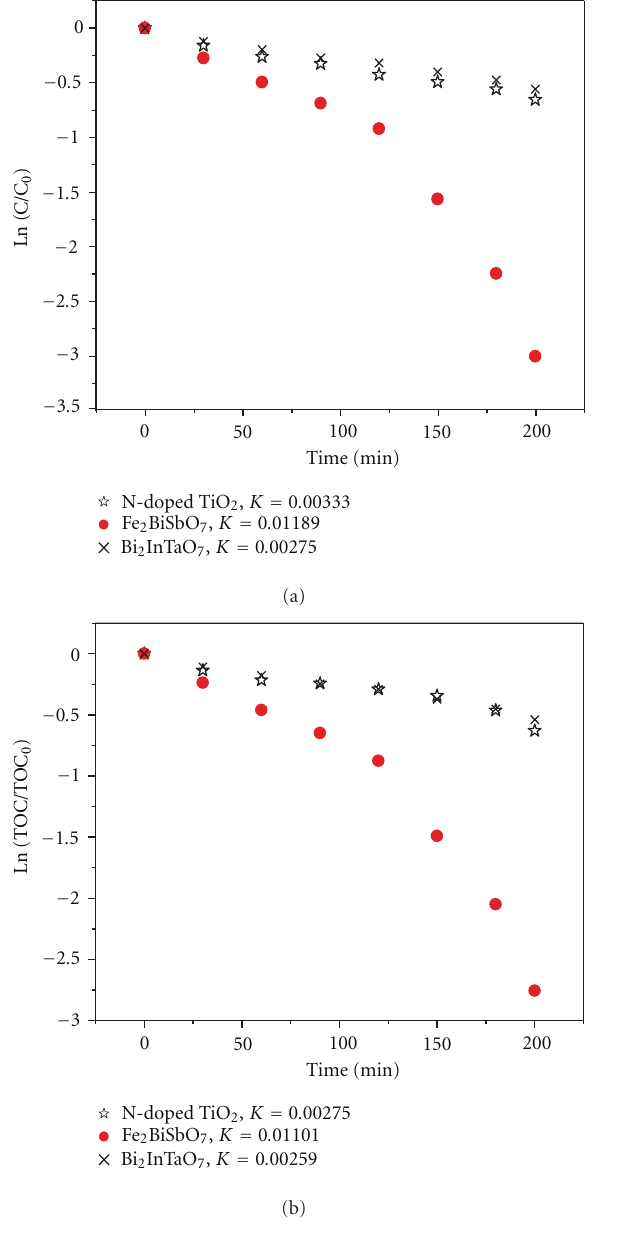
Figure 6: Observed first-order kinetic plots for the photocatalytic degradation of methylene blue with Fe 2 BiSbO 7 , Bi 2 InTaO 7 , or N- doped TiO 2 as catalyst under visible light irradiation.